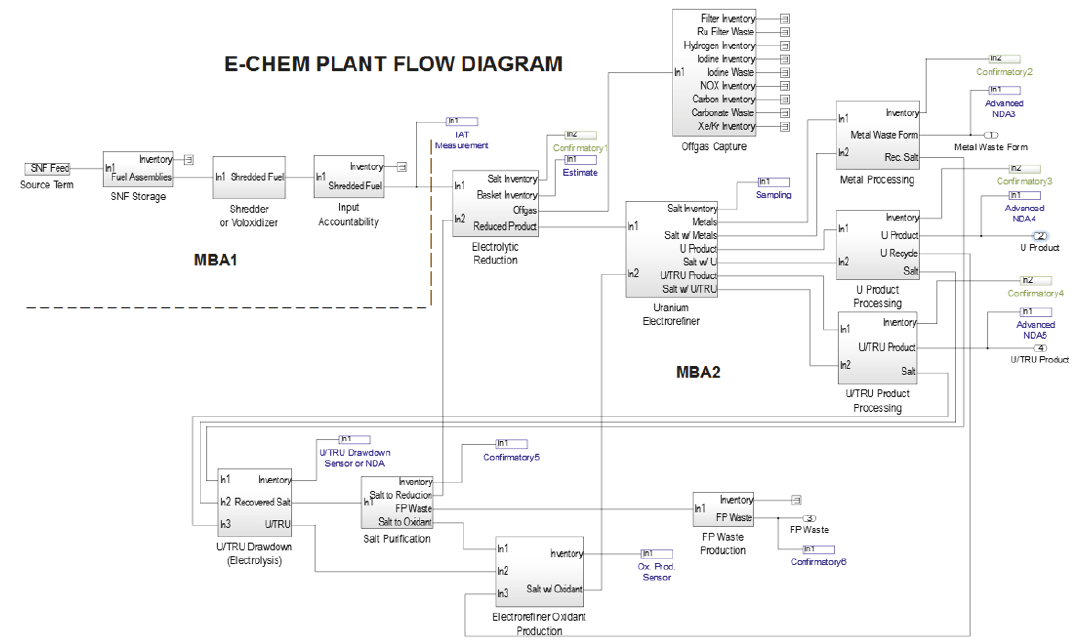
Figure 2: SSPM for an electrochemical reprocessing plant.